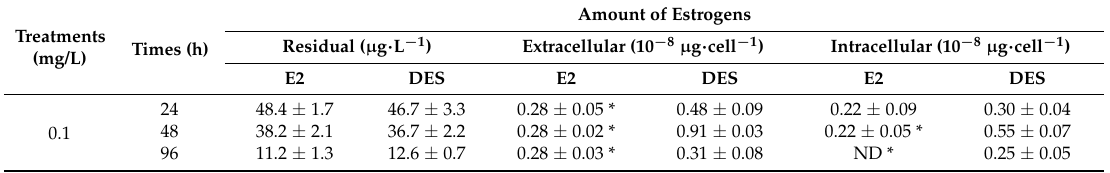
Table 3. Residual, intracellular, and extracellular E2 and DES contents under mixed